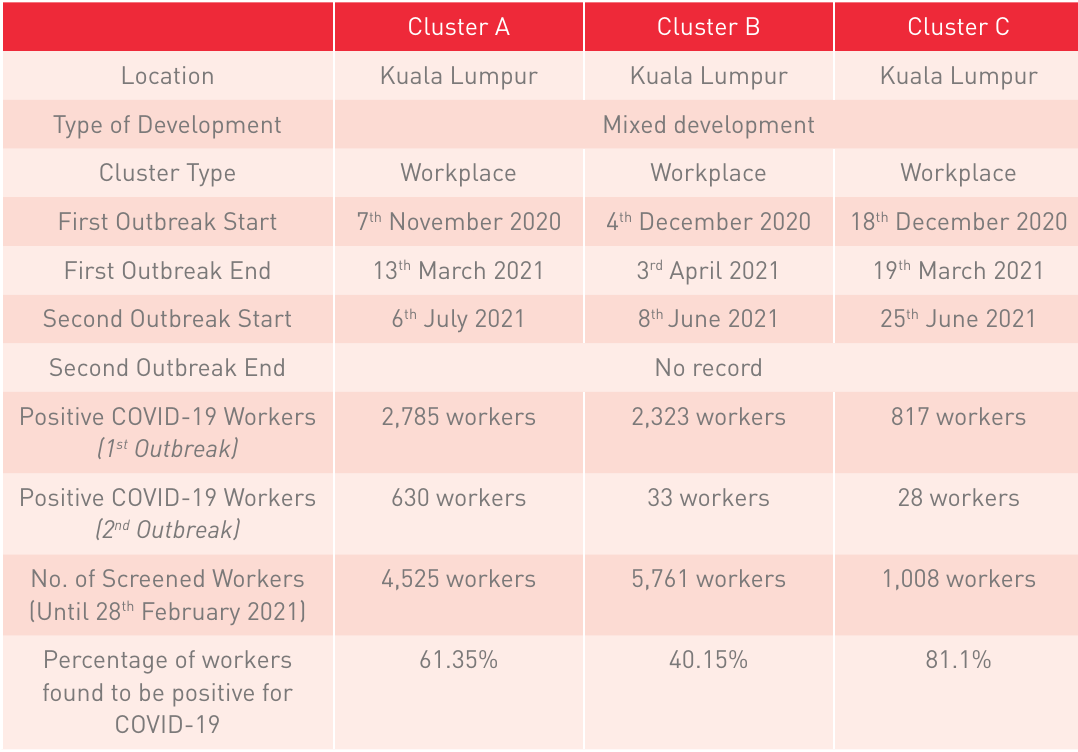
Table 2. Background of Selected Case Studies Cluster A Cluster B Cluster C Location Kuala Lumpur Type of